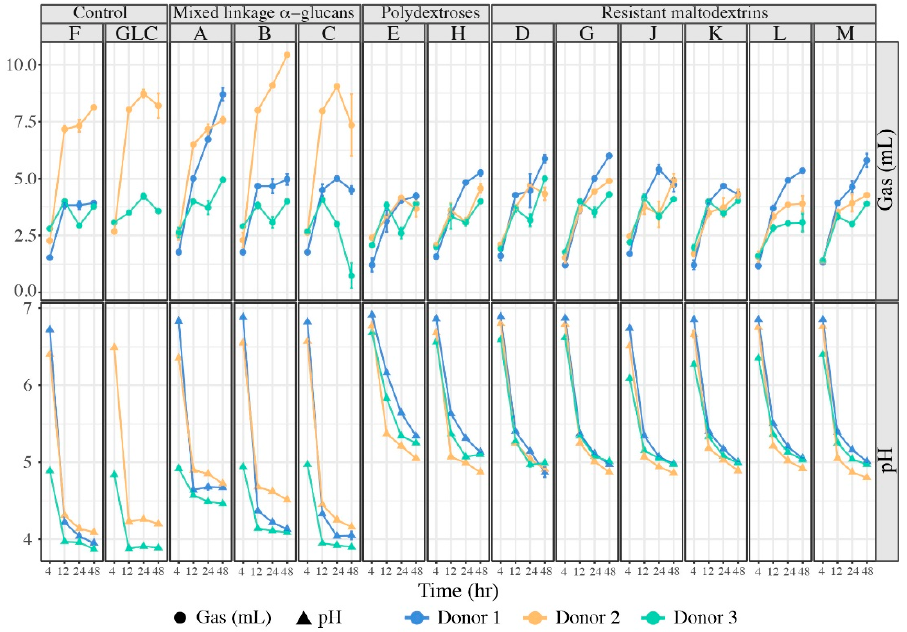
Figure 2. Gas (mL) and acid (pH) productions measured at 4–, 12–, 24–, and 48 h time points for all glucans across donor microbiota (blue: donor 1, orange: donor 2, green: donor 3). Individual glucans are represented by their letter designation; fructan (F) and glucose (GLC) were provided as controls. Error bars represent standard deviation of the mean of three separate replicates.